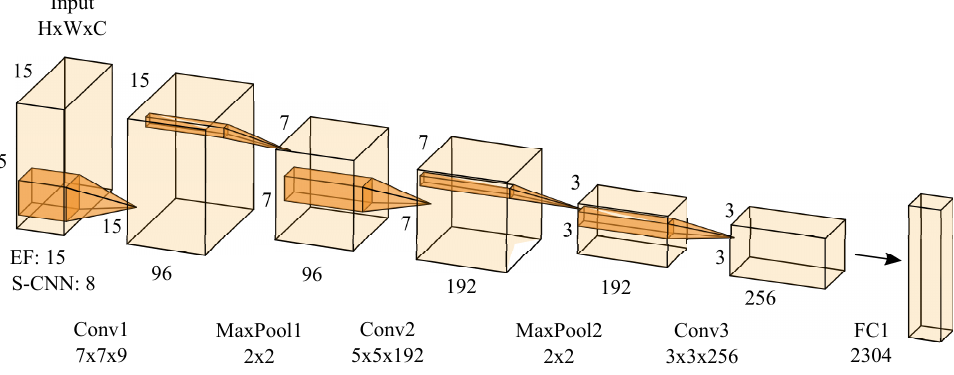
Figure 4. Parameters of the EF and S-CNN architecture.